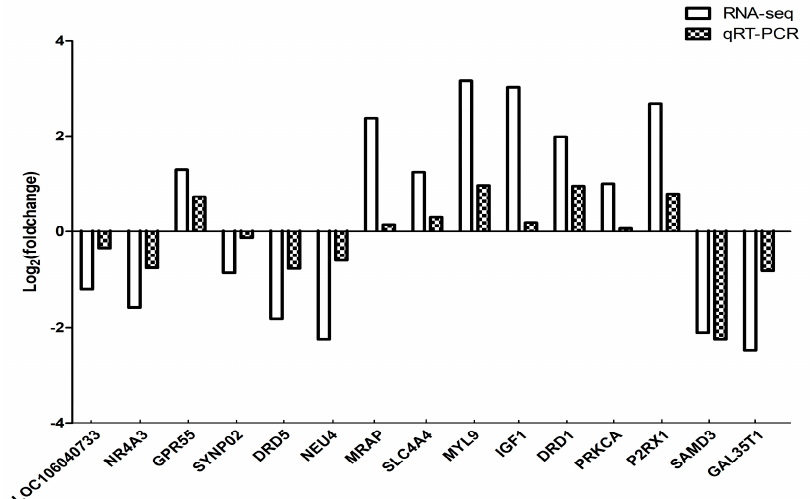
Figure 10. Comparison of qRT-PCR and RNA-seq Results. Total RNA extracted from the hypothalami, pituitary glands, and ovaries tissues that were measured by qRT-PCR analysis; relative expression levels were calculated according to the 2 − ∆∆ Ct method using beta-actin as an internal reference gene.